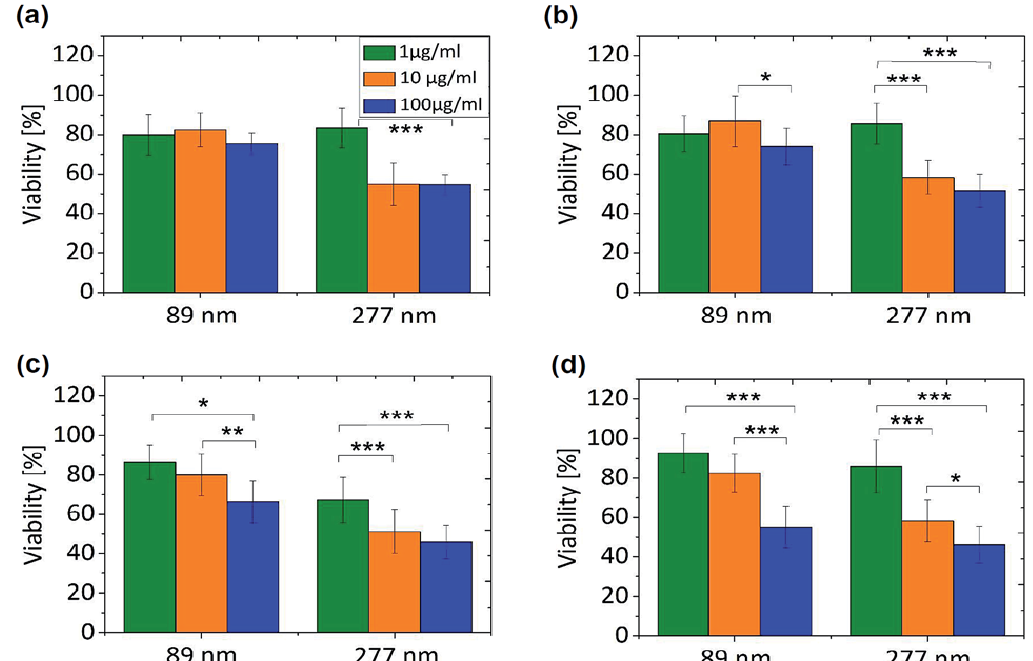
Figure 11. ( a , c ) are 3-(4,5-dimethylthiazol-2-yl)-2,5-diphenyltetrazolium bromide (MTT) results of HeLa cells cultivated with GOs of different sizes and doses for 12 h and 48 h, respectively. ( b , d ) are MTT results of macrophages cultivated with GOs of different sizes and doses for 12 h and 48 h, respectively. * p < 0.05; ** p < 0.01; *** p < 0.001; bars without mark mean a non-significant p > 0.05. Reproduced from [111] with permission of the Royal Society of Chemistry.